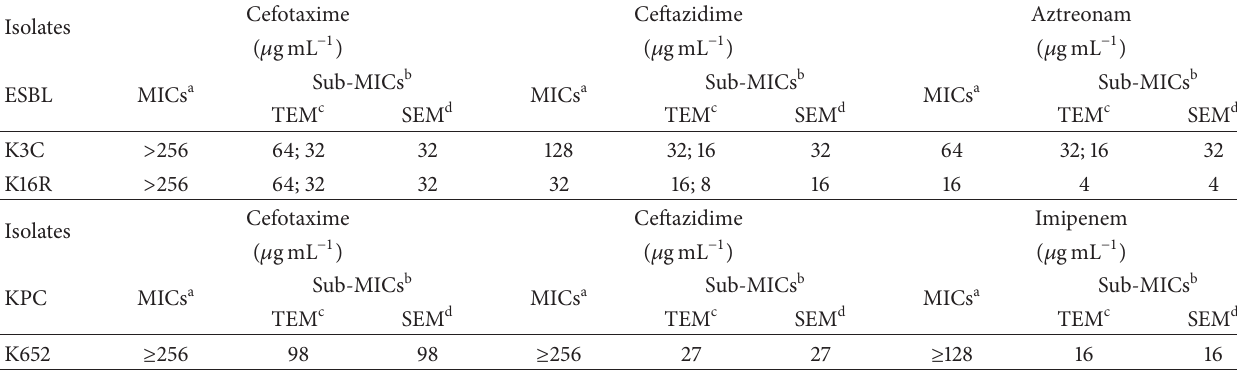
Table 1: MICs of K . pneumoniae isolates obtained in hospital and sub-MICs used for analysis by electron microscopy. Cefotaxime Ceftazidime Isolates Sub-MICs b